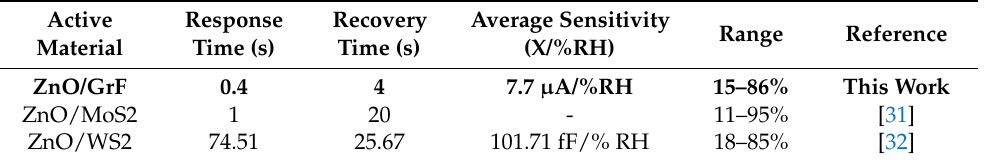
Table 3. Comparison table of GrF/ZnO and other 2D materials/ZnO composite-based humidity